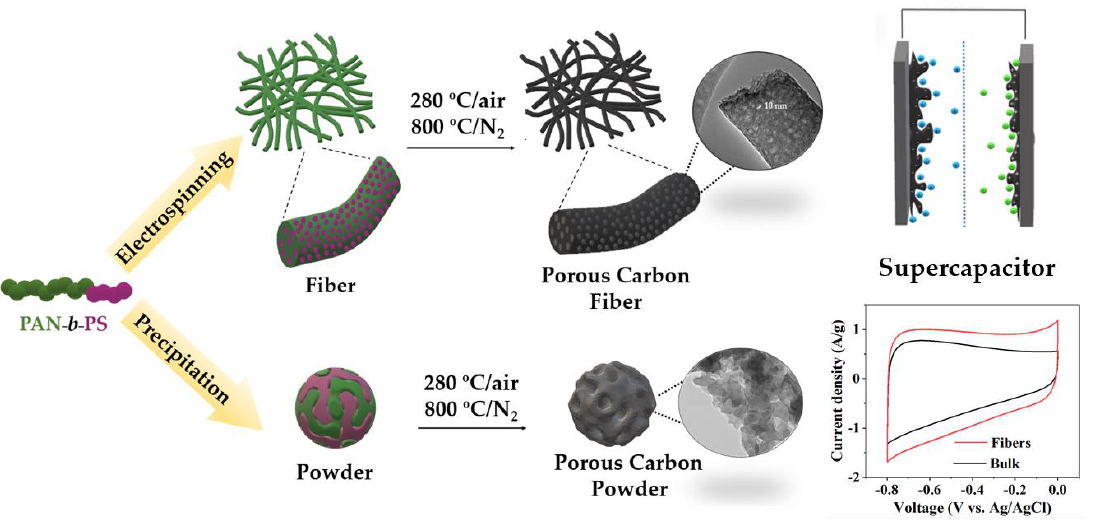
Scheme 1. Preparation scheme of porous carbon fibers and powders, from PAN − b − PS